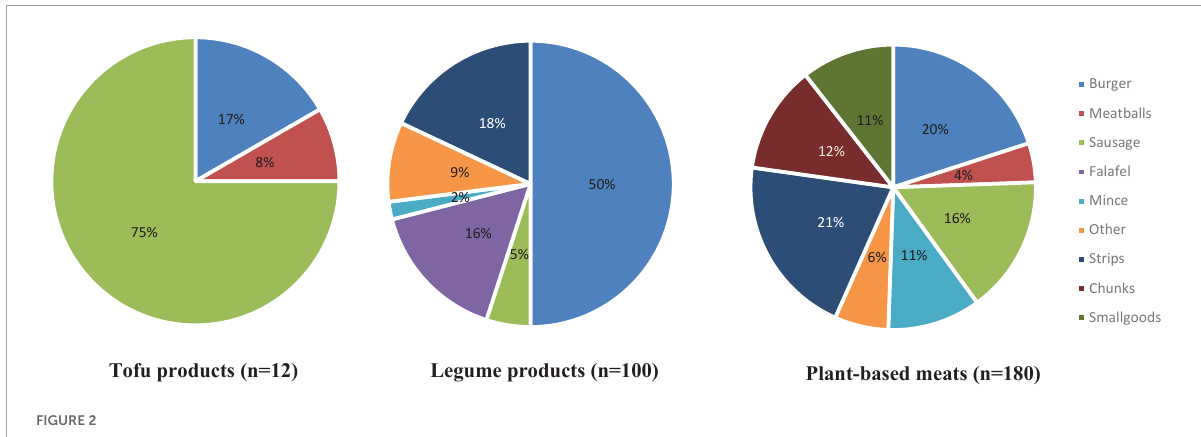
FIGURE2 The range and proportion of formats of alternative protein products.